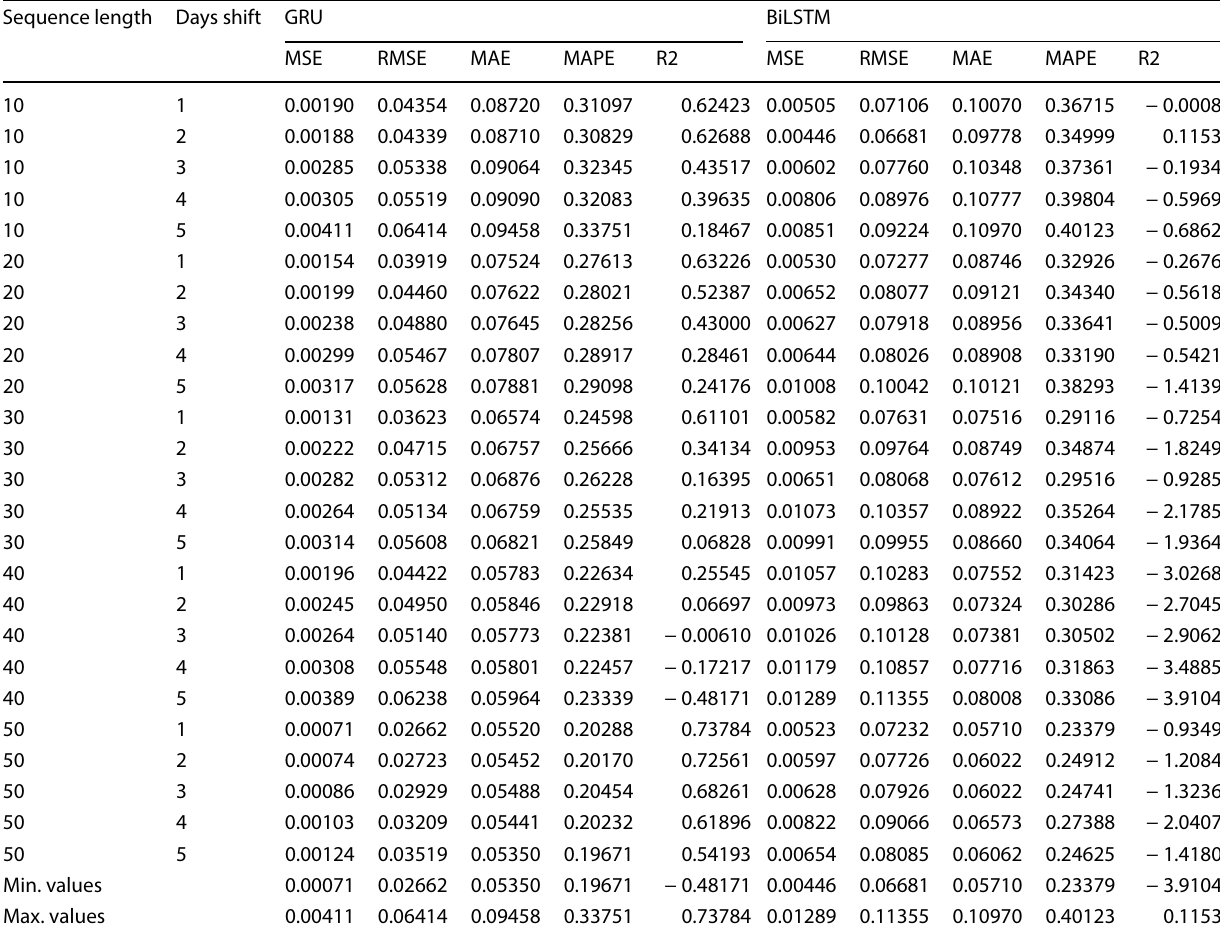
Table 6 The reported performance metrics for the “Ethereum USD (ETH-USD)” dataset using the two models (i.e., GRU and BiLSTM)